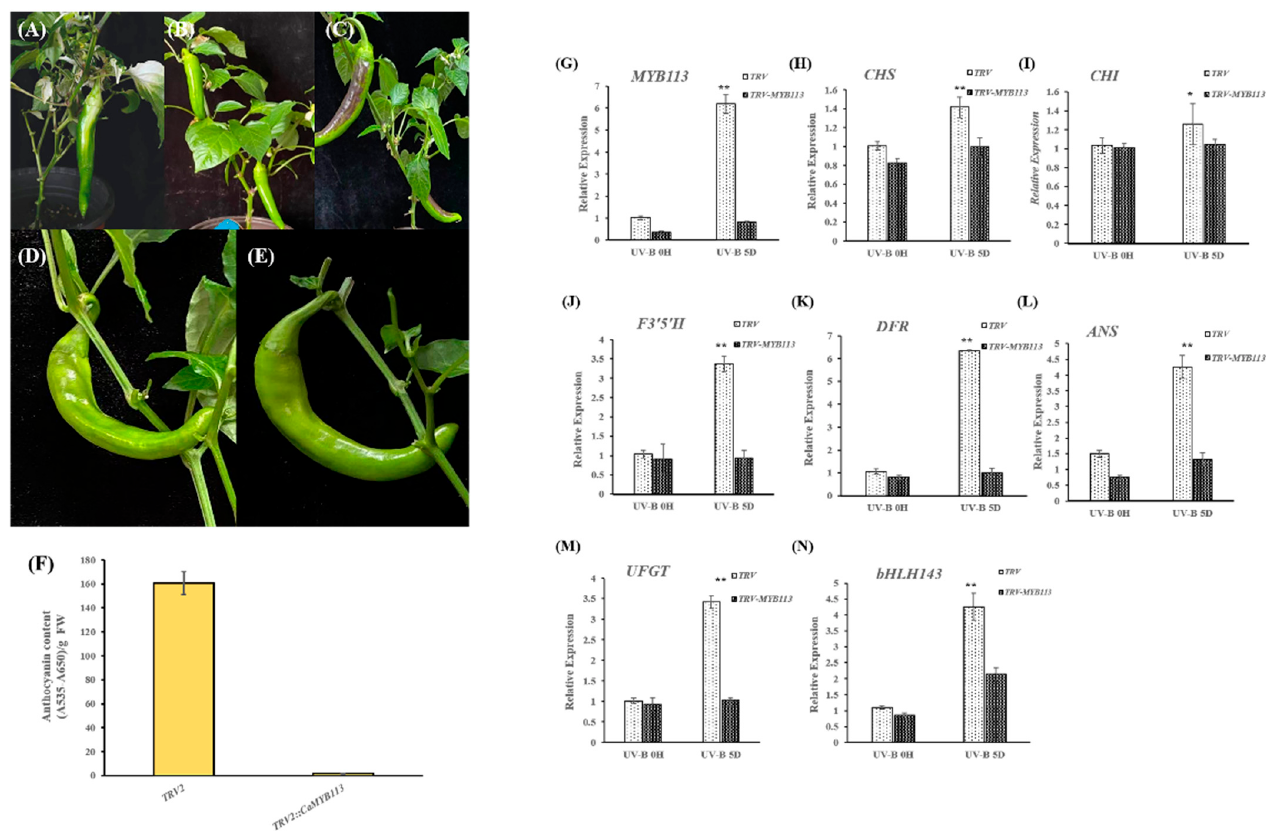
Figure 5. Analysis of VIGS of the CaMYB113 gene. ( A ) White vertical stripes appear on the pepper fruit peel inoculated with TRV2- PDS . ( B , C ) Phenotype of pepper fruits inoculated with TRV2 as controls before treatment and UV-B-induced for 5 days. ( D , E ) Phenotype of pepper fruits inoculated